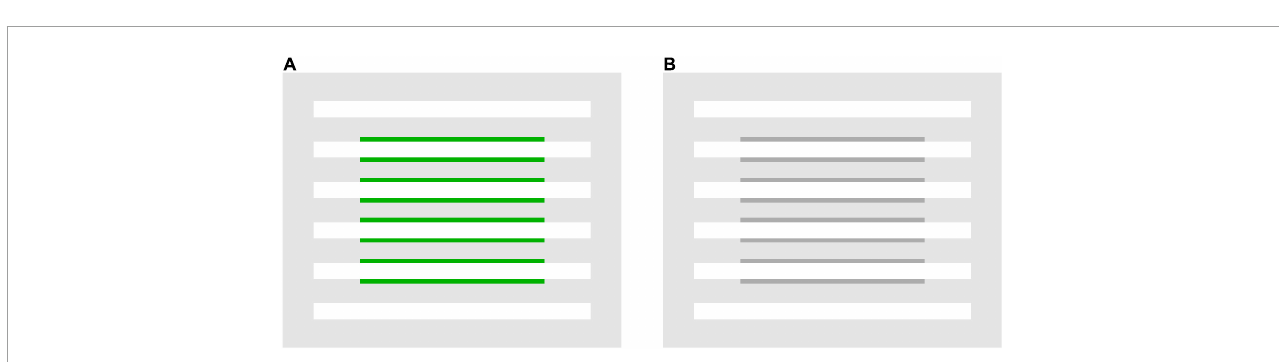
FIGURE6 Examples of flank transparency stimuli in which α (line) is outside the range of 0–1 but still convincing color spreading is observed. (A) A stimulus display with green flanks and (B) with achromatic